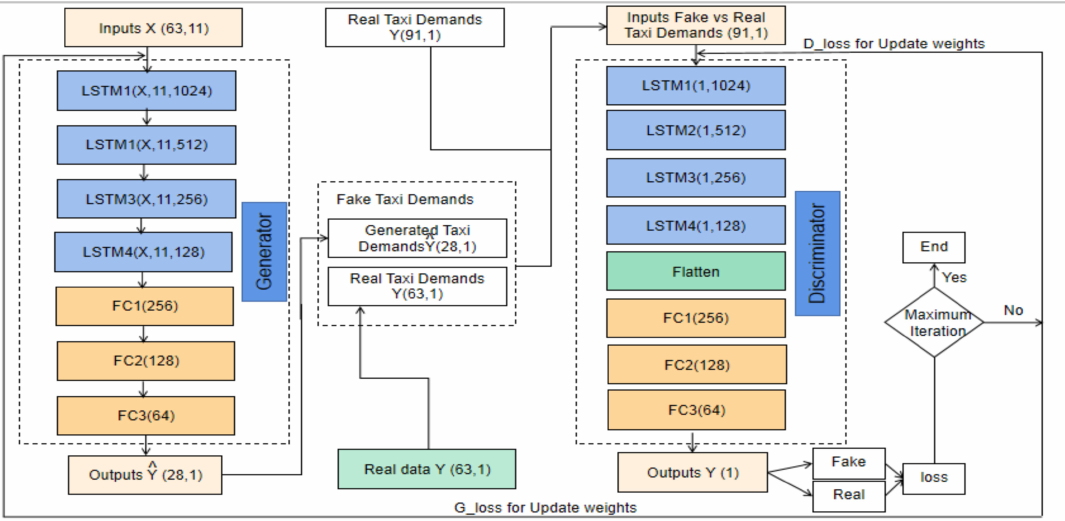
Figure 16. The structure of GAN_LSTM model.